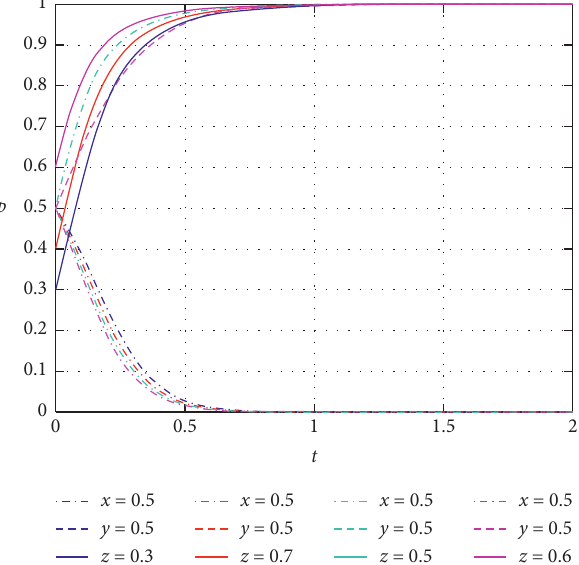
Figure 4: Change in initial willingness to participate z .